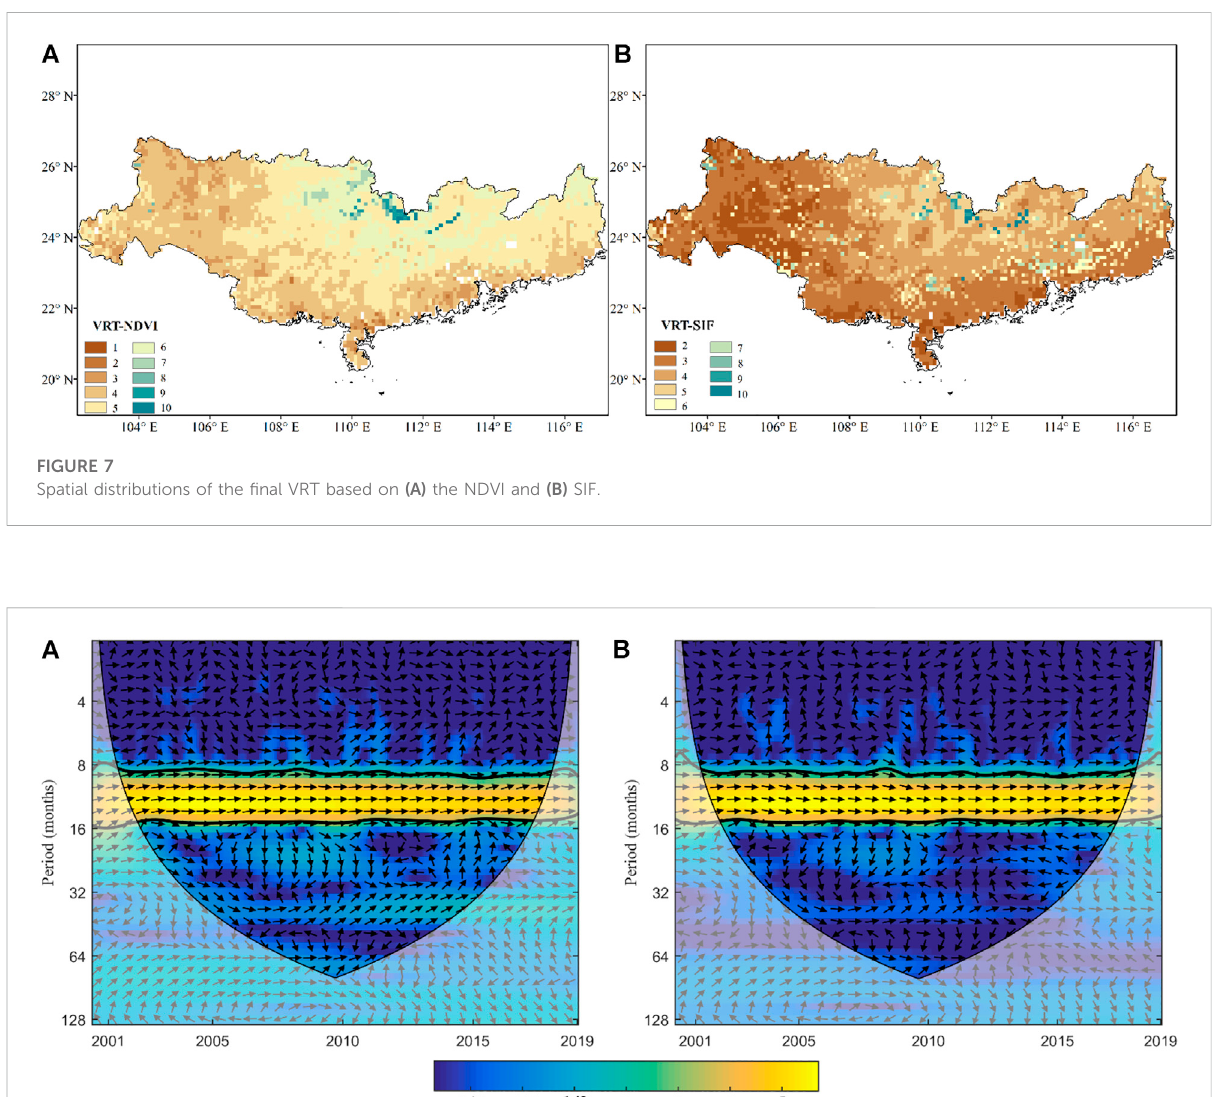
direction of the arrow represents the phase change in the two variables. The arrow to the right indicates that the two variables show a positive correlation, and the arrow to the left indicates that the two variables show a negative correlation. The arrow pointing up indicates that the change in variable 1 lags variable 2, and the arrow pointing down indicates that the change in variable 1 leads variable 2 (Chang et al., 2017). Figure 8A shows that the SPI5 and the NDVI had an obvious positive